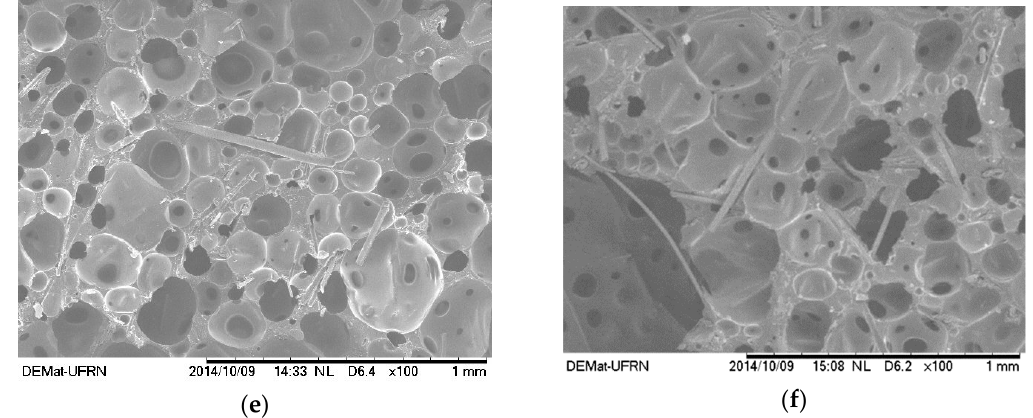
Figure 2. SEM micrographs of the dog wool fibers ( a ) in their natural state and ( b ) after treatment with 0.05 M of NaOH. Micrographs of the pure PU ( c ), PU + 10% of fibers ( d ), PU + 15% of fibers ( e ), and PU + 20% of fibers ( f ) at 100× magnification.